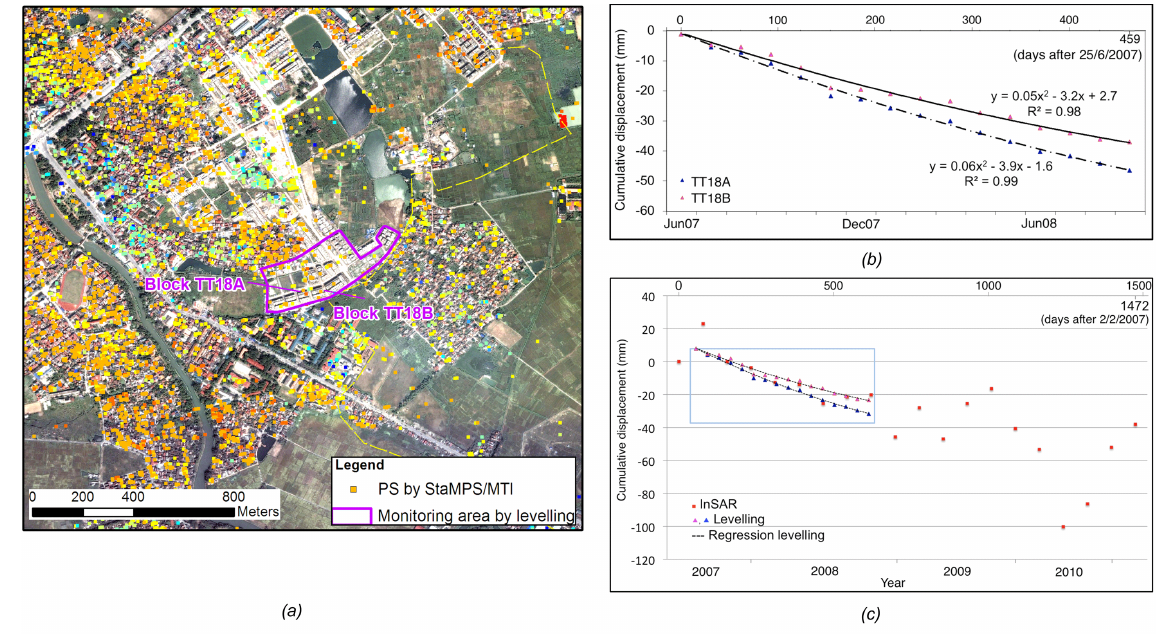
Fig. 6. (a) Monitored area by leveling in the Van Quan residential zone. For location of monitoring zone by leveling, refer to Fig. 4b, and for SP pixels in the area (color scale, refer to Fig. 3). (b) Leveling subsidence graph of blocks TT18A, TT18B (after Dinh et al., 2008). (c) Graphs of one SP located at blocks TT18A, TT18B and its leveling measurement. In order to adjust one set of data to the other one, we arbitrarily position the regression line of the leveling data through the third point of our InSAR time